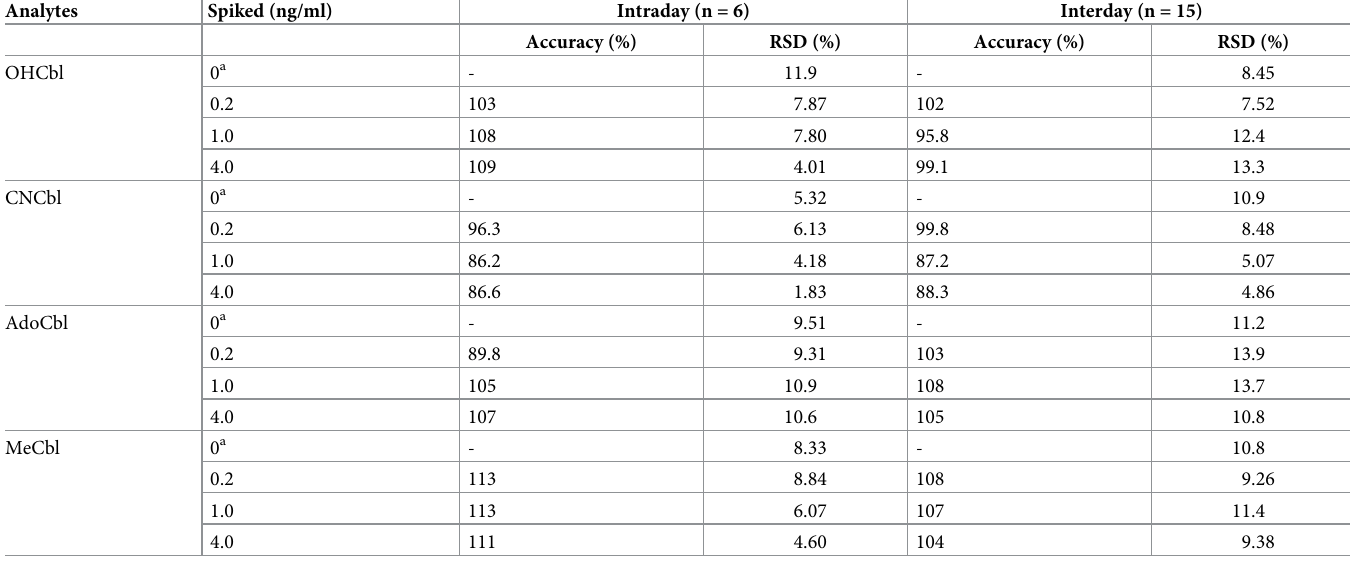
Table 4. Method validation for SPE-HPLC-MS/MS analysis of four cobalamins: Precision and recovery values at different concentrations (0 ng/ml, 0.2 ng/ml, 1.0 ng/ml and 4.0 ng/ml) in quality control samples. Analytes Spiked (ng/ml)